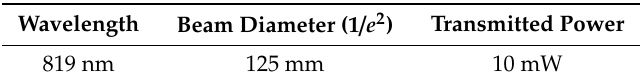
Table 2. ARTEMIS technical features.